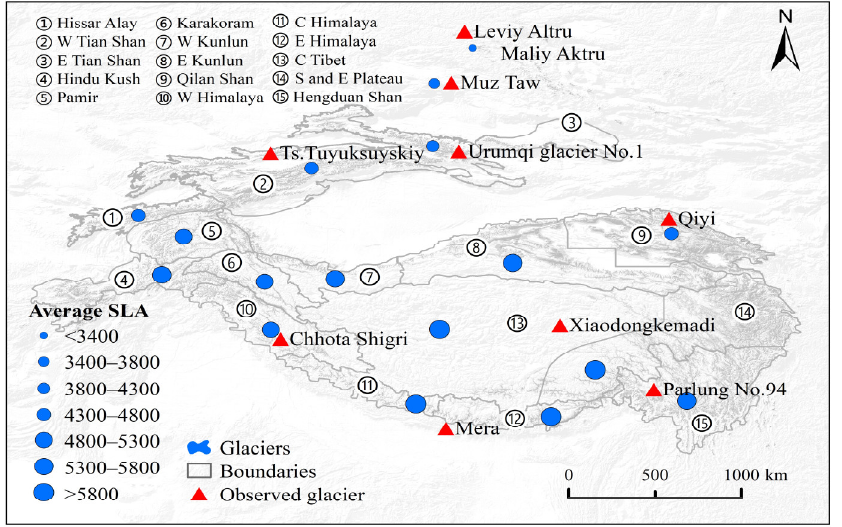
Figure 11. Spatial distribution of the average SLA in High Mountain Asia over the period of 2000–2021. The blue dots represent the average SLA of the glacier in the different regions.